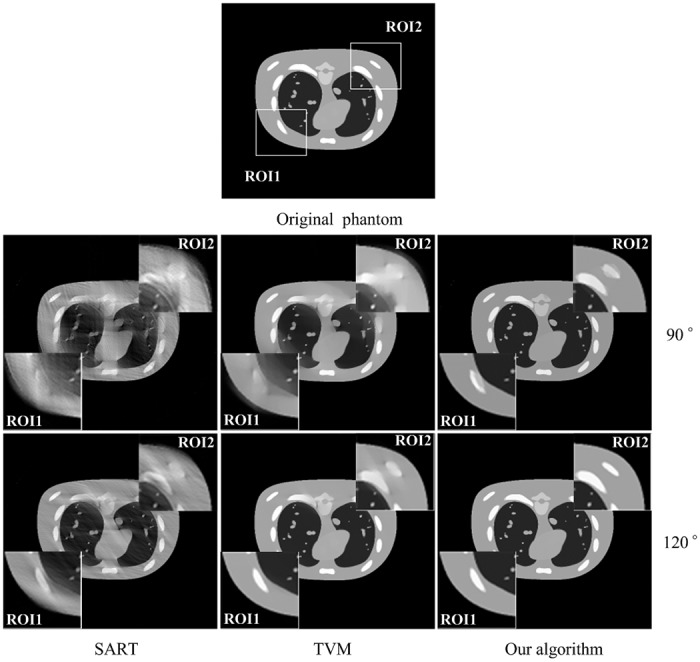
The tomographic results of NCAT phantom from noise-free projection dataset.The image on the top is the original phantom. The following rows are the results reconstructed from scanning angular ranges [0, 90°] and [0, 120°], respectively. Images from left to right in each row present the results reconstructed by SART algorithm, TVM algorithm and our algorithm, respectively. The gray scale window is set to [0, 1.0].